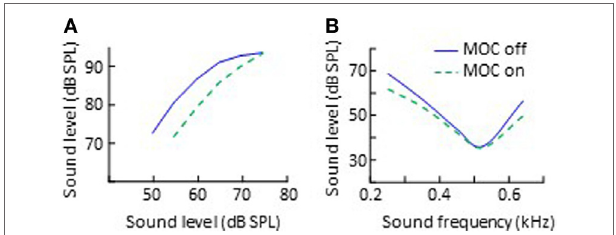
FiGURe 4 | Effects of CAS-evoked medial-olivocochlear (MOC) activation on human behaviorally inferred cochlear input/output curves (A) and psychoacoustical tuning curves (B) . The data in panel (A) are re-plotted, in modified form, from Fig. 2 in Krull and Strickland (83), subject S1. The data in panel (B) are re-plotted, in modified form, from Fig. 3 in Aguilar et al.